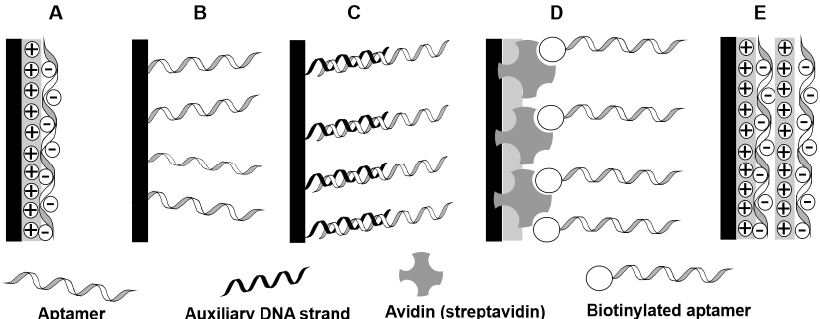
Figure 6. Common immobilization protocols applied for aptamer immobilization. ( A ) electrostatic immobilization on charged support; ( B ) covalent attachment via terminal functional group; ( C ) Affinity immobilization by hybridization with auxiliary single-stranded DNA sequence; ( D ) immobilization via avidin (streptavidin)—biotin binding; ( E ) inclusion in polyelectrolyte layers or ordered structured by preferably non-covalent